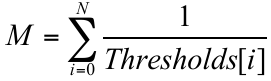
Paper —Using Efficient TRNGs for PSEUDO Profile in National eID